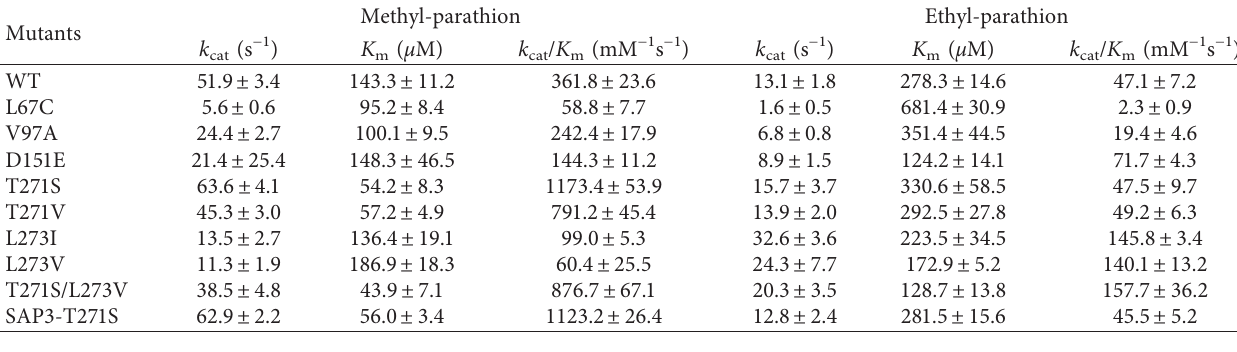
Table 1: Kinetic parameters of MPH